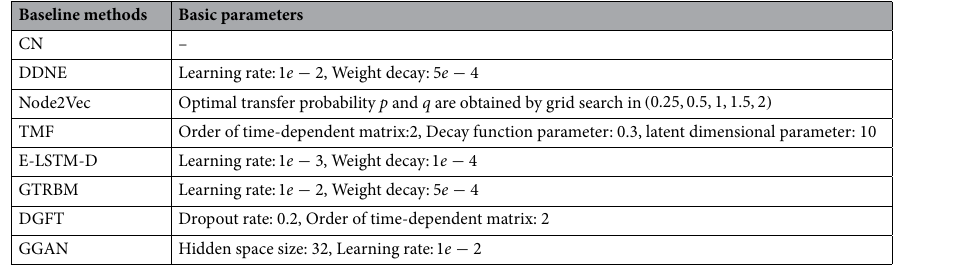
Table 4. Parameters of the eight baseline